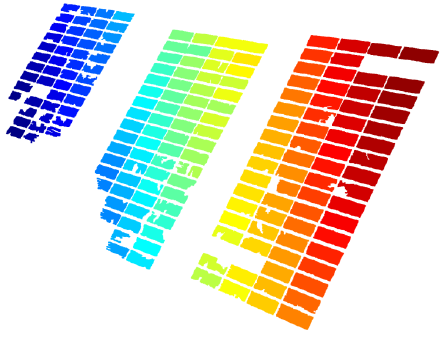
Figure 7. Isolation of the PV panels by image treatment (no fault).